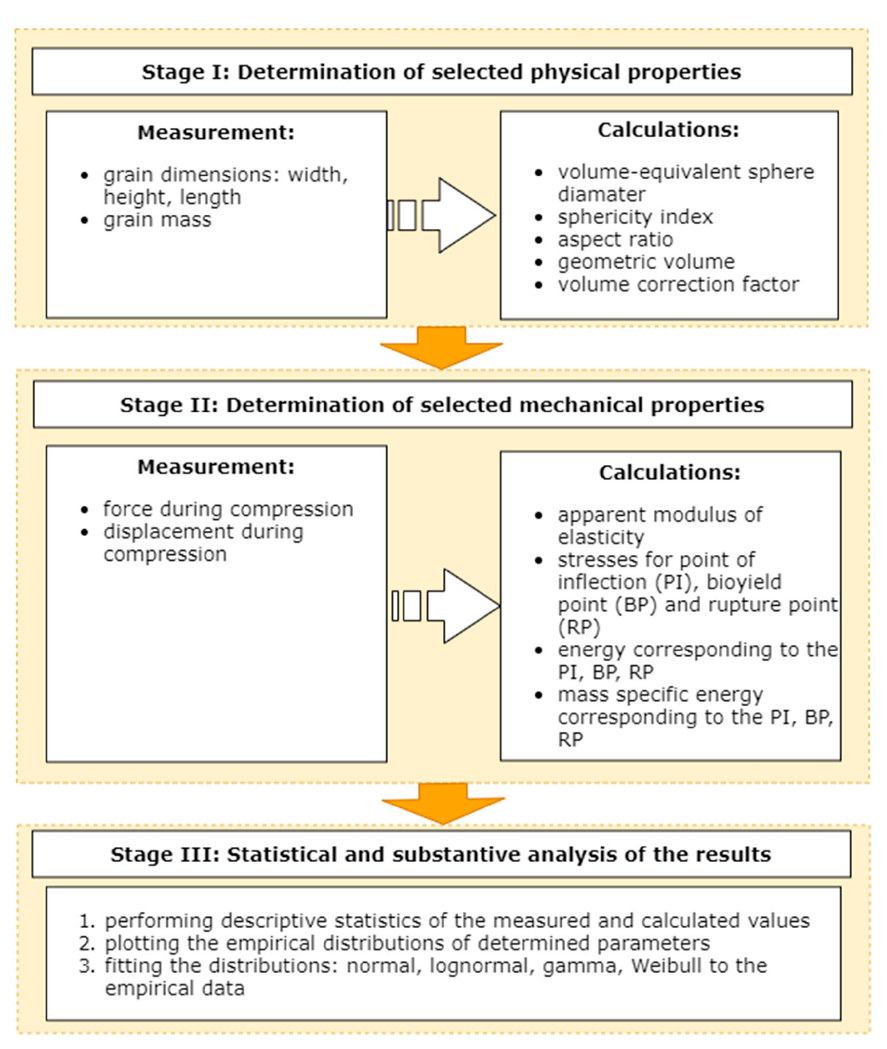
Figure 1. The flowchart of the study design.